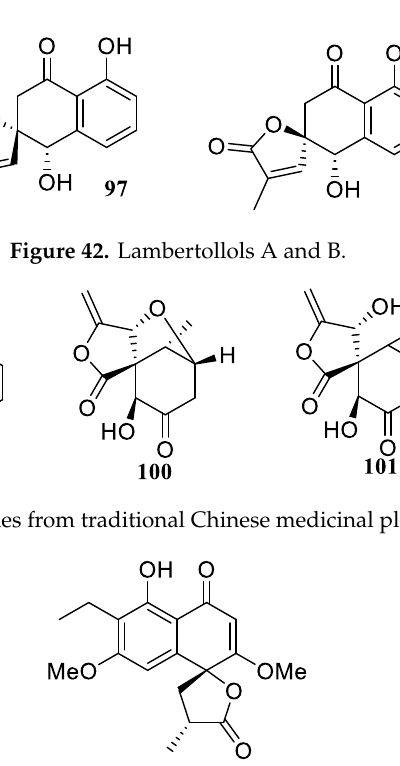
Figure 42. Lambertollols A and B.